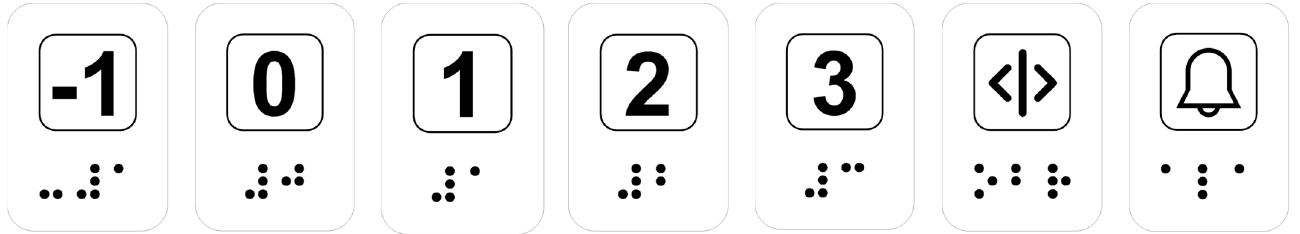
Figure 7. Design of the plastic cover attached over the cantilever ‐ like buttons of the IoT device.